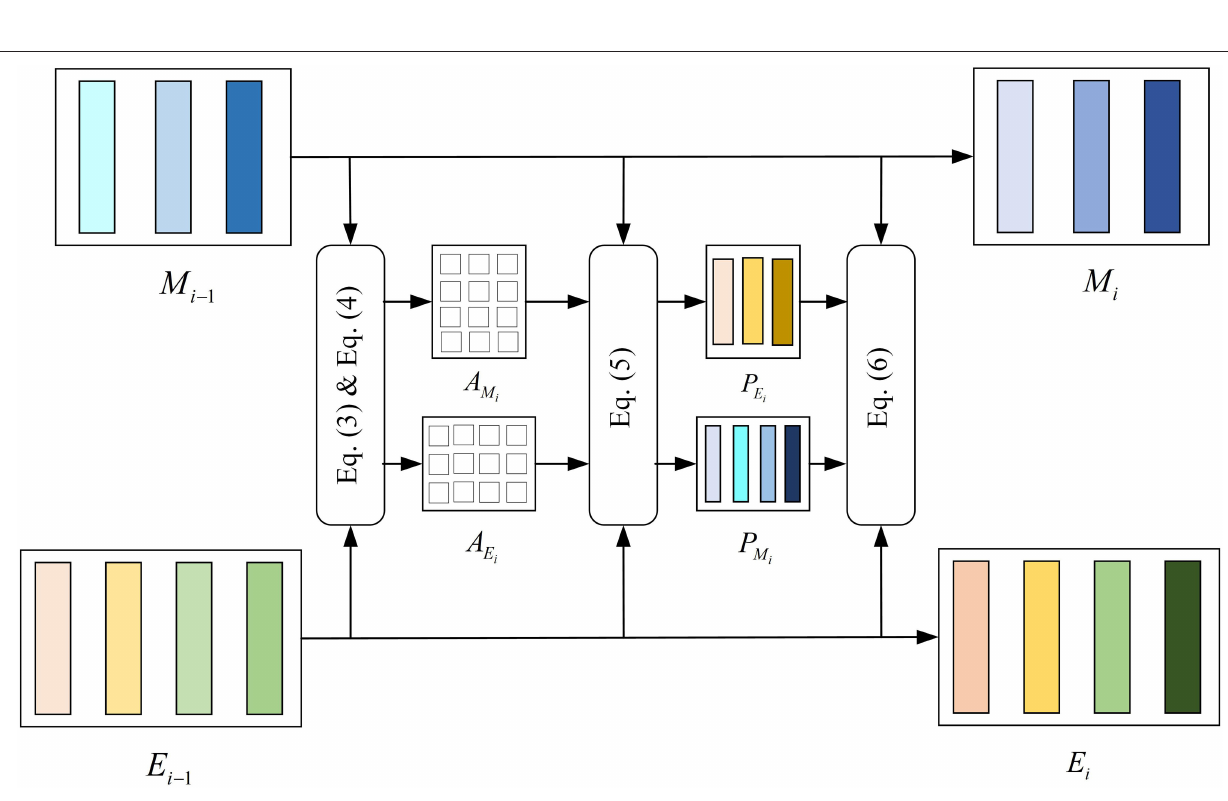
FIGURE 2 | Structure of the dense co-attention (DCA)